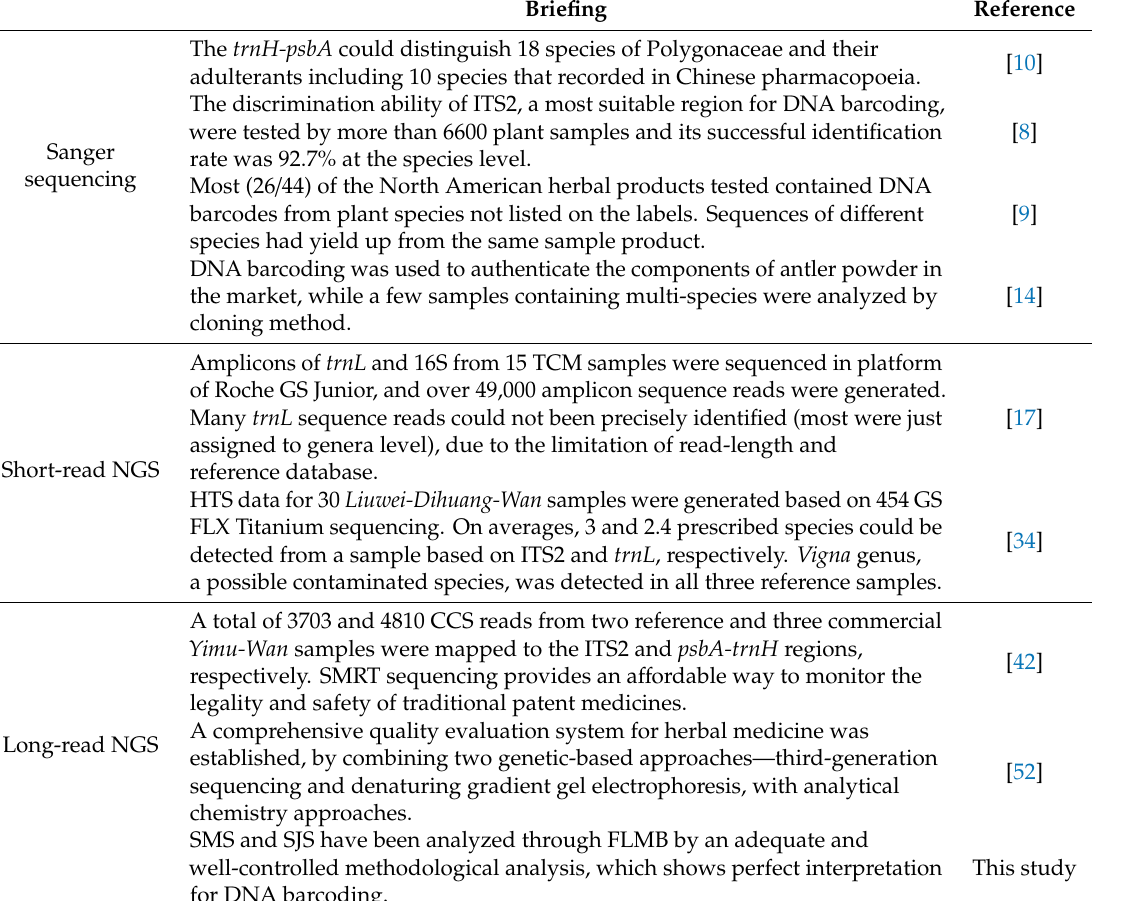
Table 4. Cases of di ff erent sequencing approaches applied to DNA barcoding of herbs.